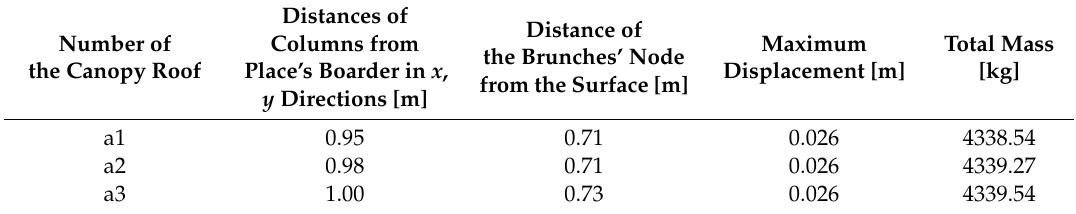
Table 5. The results of the simulation assuming bar lengths within the scope of 1.0 - 3.0 m.